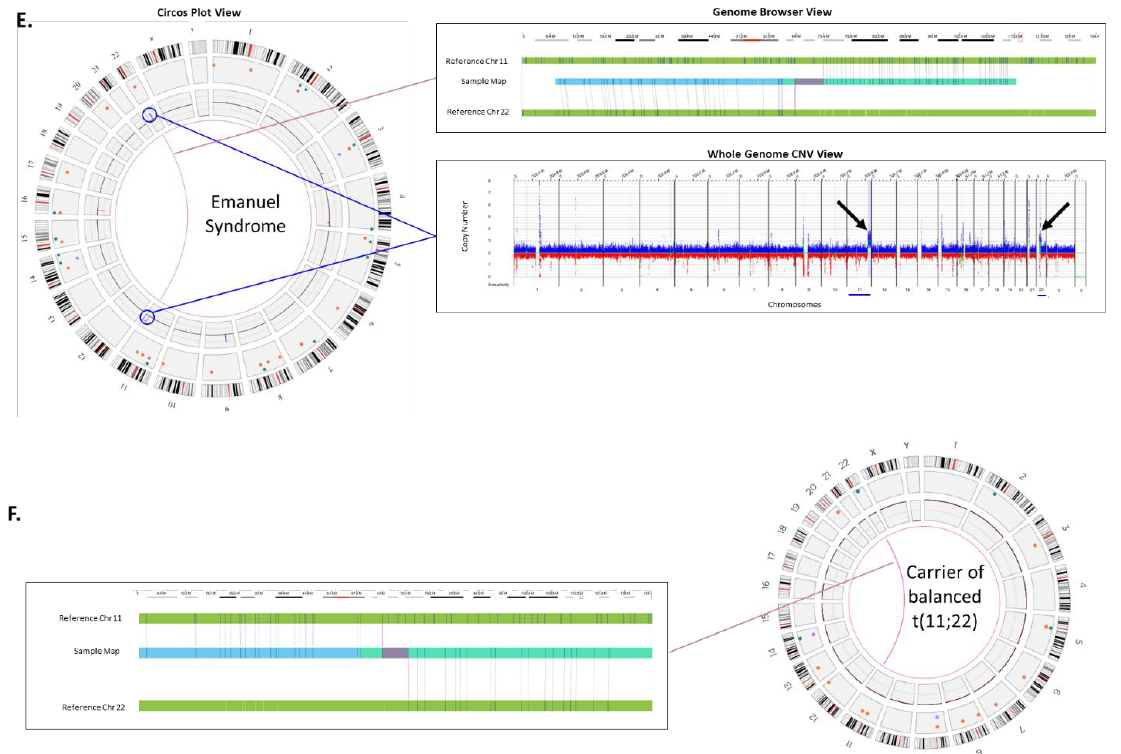
Figure 2. Examples of structural variants (SVs) identified by Optical genome mapping (OGM). OGM circos plots are automatically generated and the default view is composed of the following layers: the outer circle displays cytoband locations, the middle circle displays color-coded interstitial SVs that were identified in those particular locations, and the innermost circle displays observed copy number changes for each chromosome or region. Translocations are reported as lines in the center connecting the genomic loci involved. ( A ) Left panel: represents the circos plot with a copy number gain visible and highlighted with a blue box on the circos plot around the inner circle of the CNV plot highlights the chromosome 21 gain, the right panel shows the whole genome CNV profile, a linear visualization of the CNV changes across the genome. The Y -axis represents the copy number change and X -axis lists the chromosome numbers. Gains are highlighted in blue while losses are highlighted in red. Here, the black arrow points to chromosome 21 that has 3 copies. ( B ) Right panel: shows the circos plot displaying SVs and an aneuploidy in the sample. The blue box around the inner circle of the CNV plot points to chromosome X gain. Left panel: the CNV plot shows a gain of chromosome X. The black arrow points to chromosome X, which is present in four copies. ( C ) Left panel: shows the circos plot summary displaying SVs in the sample. The orange box around a region on chromosome 22 highlights a pathogenic deletion. Top right panel: The genome browser view details the alignment of the sample’s consensus map (light blue bar) with the reference consensus maps (light green bars) and provides the detail of the structural variation. Here, the sample’s map alignment to the reference maps of chromosomes 22 illustrates a large ~3 Mbp deletion (light red). Bottom right panel: CNV plot showing loss on chromosome 22 (black arrow). ( D ) Right panel: shows the circos plot summary displaying SVs in the sample. The green circle in the middle circle highlights an insertion identified on chromosome X. Left panel: the genome browser view details the alignment of the sample’s consensus map (light blue bar) with the reference chromosome X (light green bars) showing a highlighted region on the sample map that contains an insertion. The insertion is within the FMR1 gene, inferred (and confirmed) to be a triplet repeat expansion. ( E ) Left panel: shows the circos plot summary displaying SVs in the sample. Blue lines point to regions on chromosomes 11 and 22 with CNV gains. The purple line points to a translocation also observed between chromosomes 11 and 22. Top right panel: The genome browser view detailing the alignment of the sample’s consensus map (light blue bar) with the reference chromosome 11 and 22. Here, the sample’s map aligns to two reference chromosomes indicating a translocation. Bottom right panel: CNV plot showing CNV gains on chromosomes 11 and 22 (black arrows). ( F ) The carrier mother of the case in Figure 2E showing a balanced translocation between chromosomes 11 and 22, but no CNV gains on either chromosome 11 or 22.